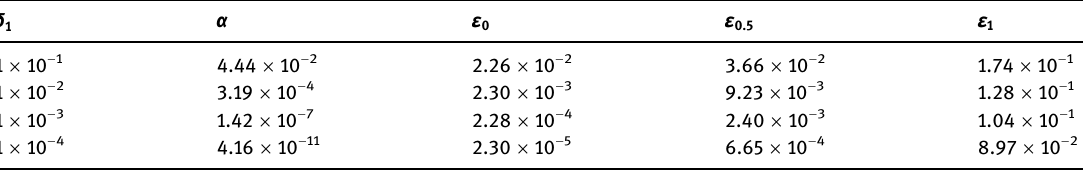
Table 3: Relative errors ε y of Example 3 δ